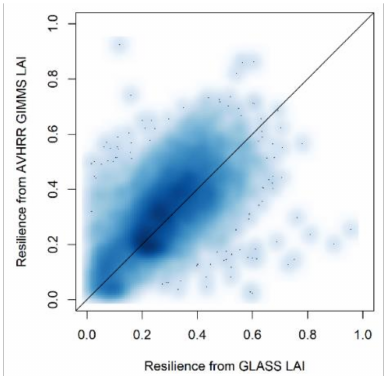
Figure 4. Terrestrial ecosystem resilience (from GLASS LAI) vs terrestrial ecosystem resilience (from GIMMS AVHRR LAI 3g).